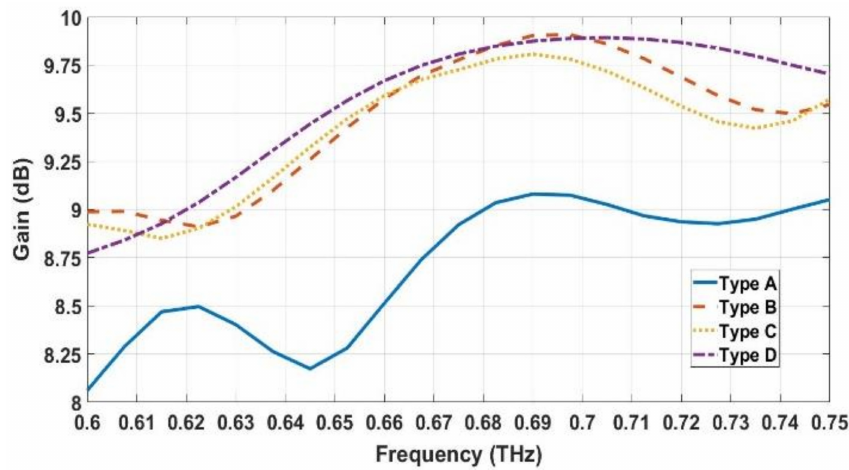
Figure 6. Comparison of peak gain for the four proposed types.